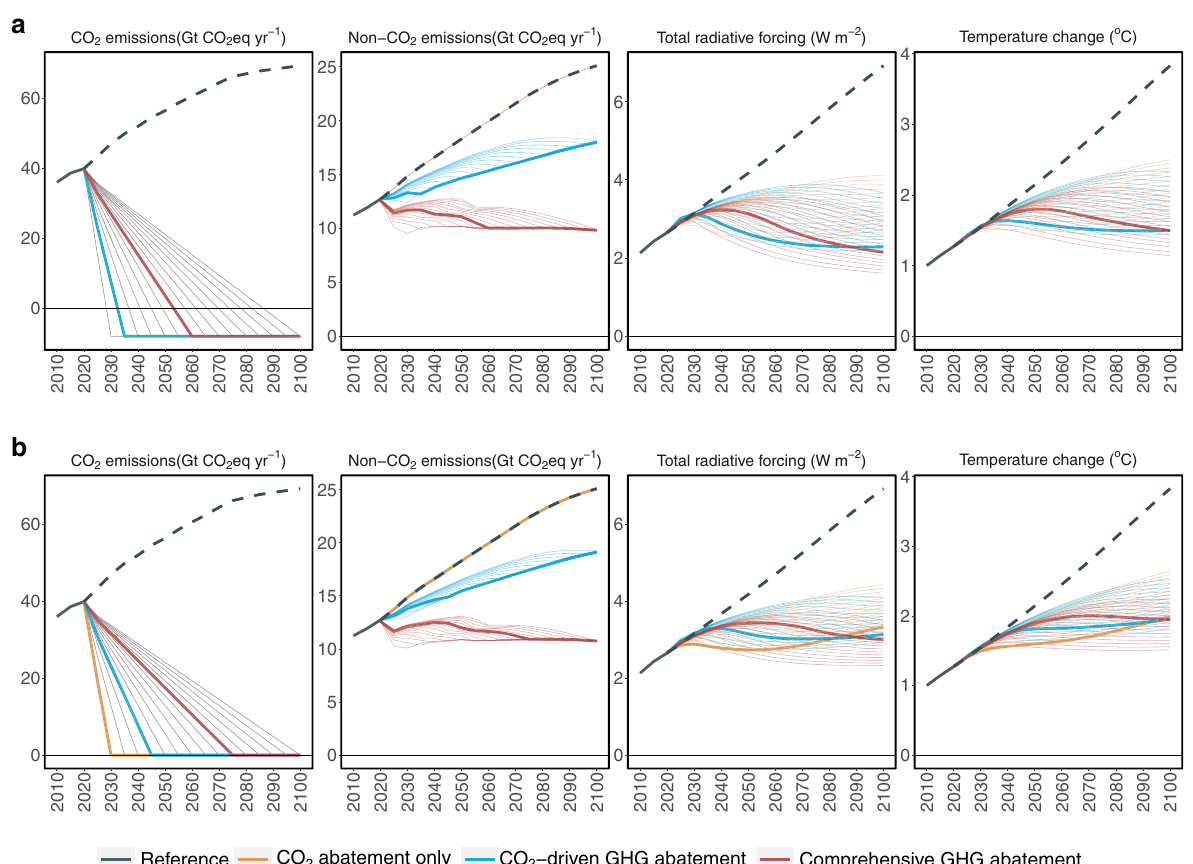
Fig. 2 Global emission and climate results. a 1.5 °C and ( b ) 2 °C scenarios, including total CO 2 emissions from fossil fuels and land-use changes, total non- CO 2 GHG (CH 4 , N 2 O, HFCs, P.F.C.s, and SF 6 ) emissions, total radiative forcing, and global mean surface temperature change. Reference assumes no